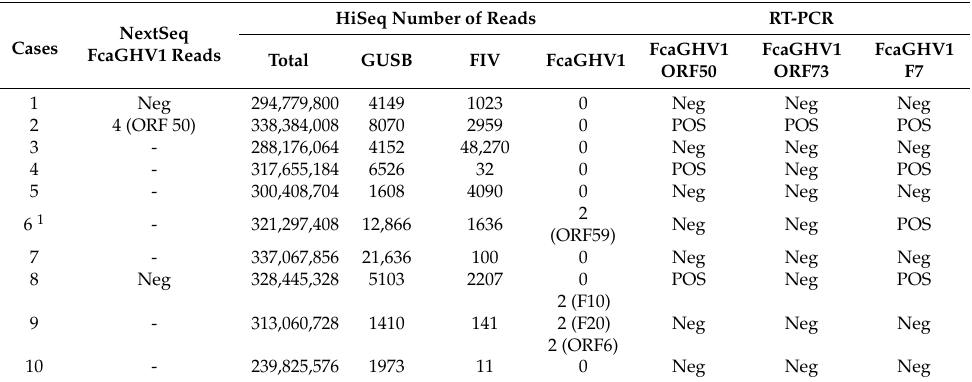
Table 1. Summary of transcriptome analyses of feline immunodeficiency virus associated lymphoma from FcaGHV1 infected cats.